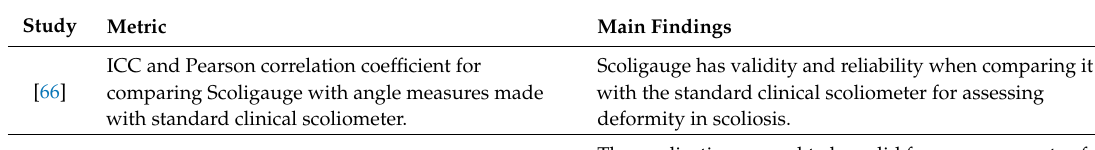
Table 11. Metrics and main findings of the reviewed